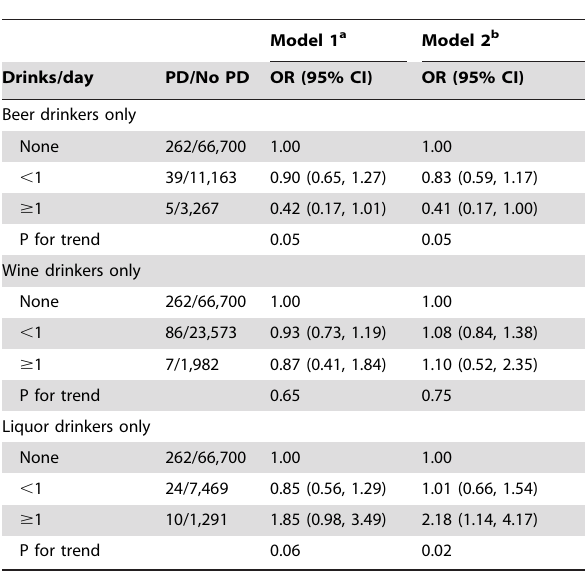
Table 3. Odds Ratios of Parkinson’s Disease According to Exclusive Drinkers of a Specific Type of Alcoholic Beverage, NIH-AARP Diet and Health Study,